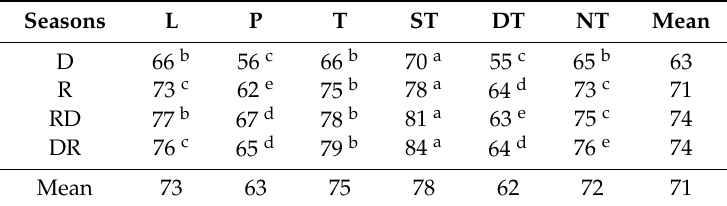
Table 6. Crumb formation (%) at di ff erent soil tillage and seasons.